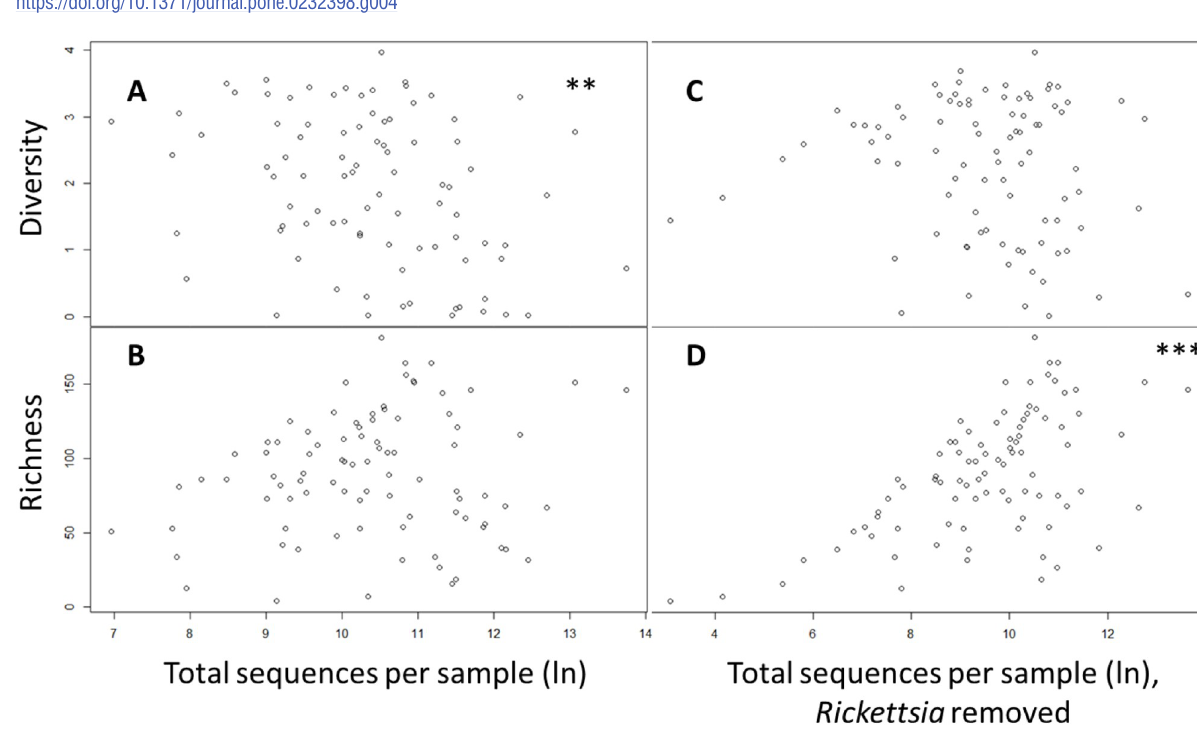
PLOS ONE | https://doi.org/10.1371/journal.pone.0232398 May 15,